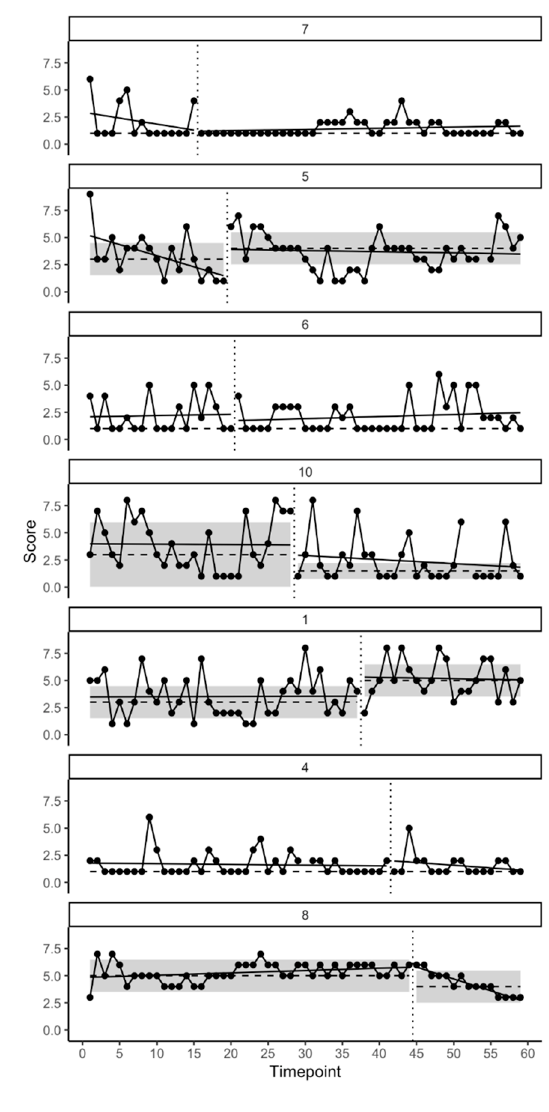
Figure 1. SCED data for all participants on daily single measures of stress ( left ) and EA ( right ). Participant data are ordered via the order in which they received the intervention. Vertical dotted lines denote the data point at which the intervention was delivered. Shading denotes the one median absolute deviation from the median. Dashed horizontal lines denote the median while solid lines denote within-phase OLS regression trend lines.